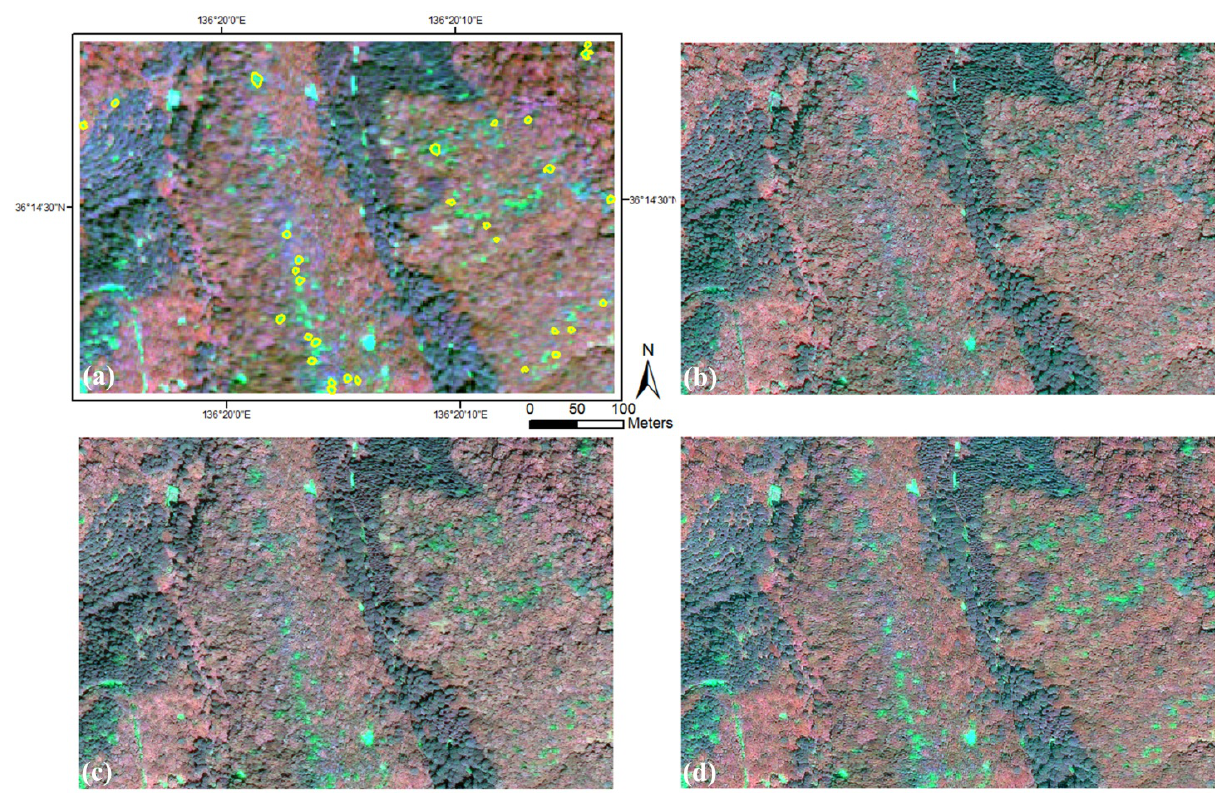
Figure 2. GeoEye-1 image (NIR, R, G bands) of ( a ).the forested study area, ( b ) IHS, ( c ) BT, and ( d ) SFIM pansharpened images. Yellow polygons in (a) delineate reference polygons of damaged or killed trees. A standard deviation contrast stretch of 3.0 was used for display